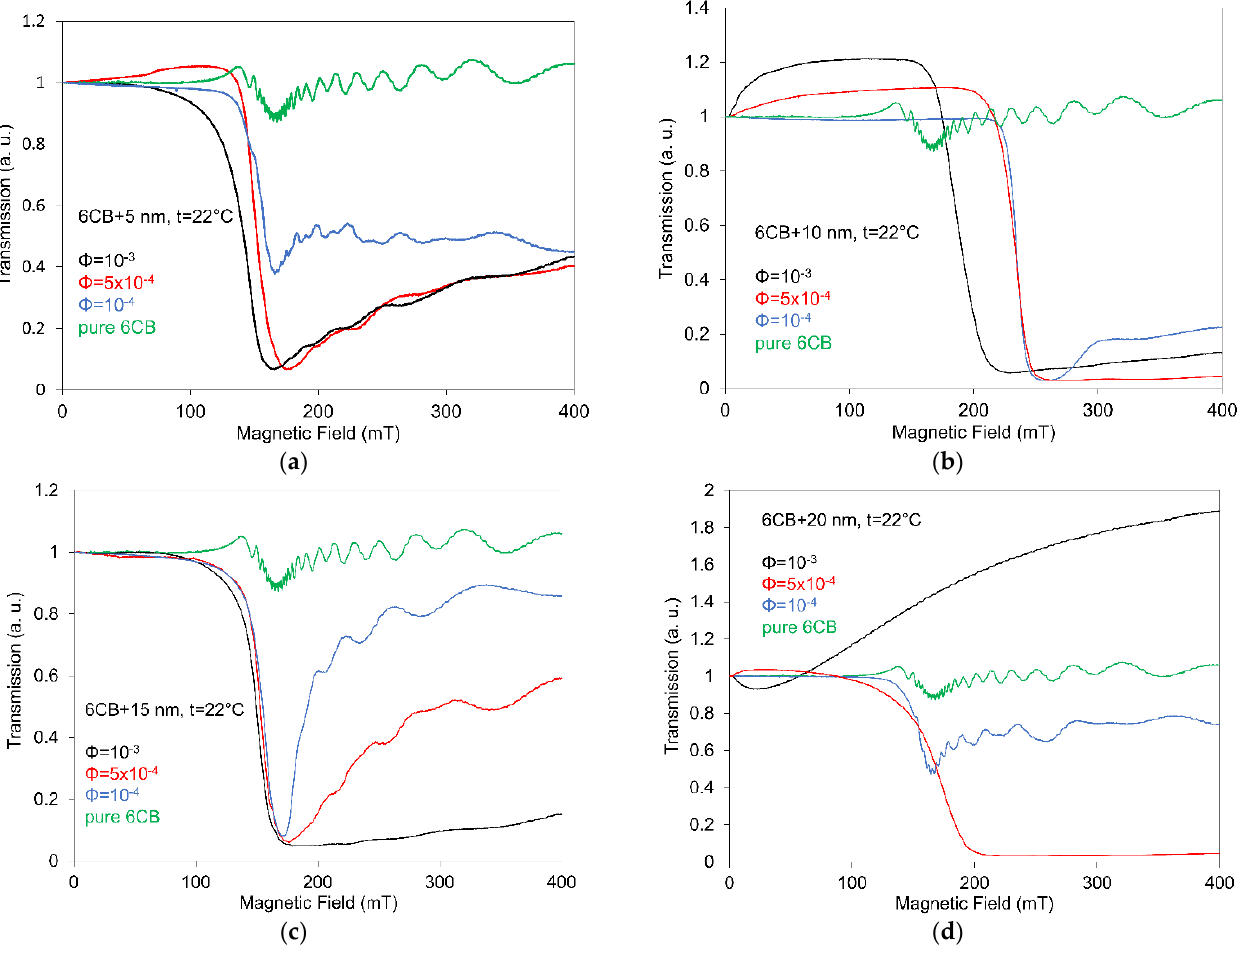
Figure 3. Dependences of light transmission on magnetic field for 6CB liquid crystal doped with spherical magnetic nanoparticles with size 5 nm ( a ), 10 nm ( b ), 15 nm ( c ) and 20 nm ( d ) each of concentrations 10 − 4 , 5 × 10 − 4 and 10 − 3 , including pure 6CB.